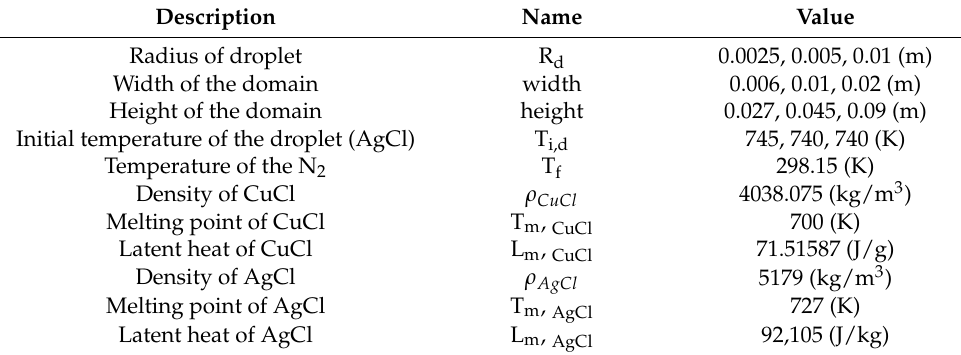
Table 1. Geometric dimensions and thermophysical properties of the